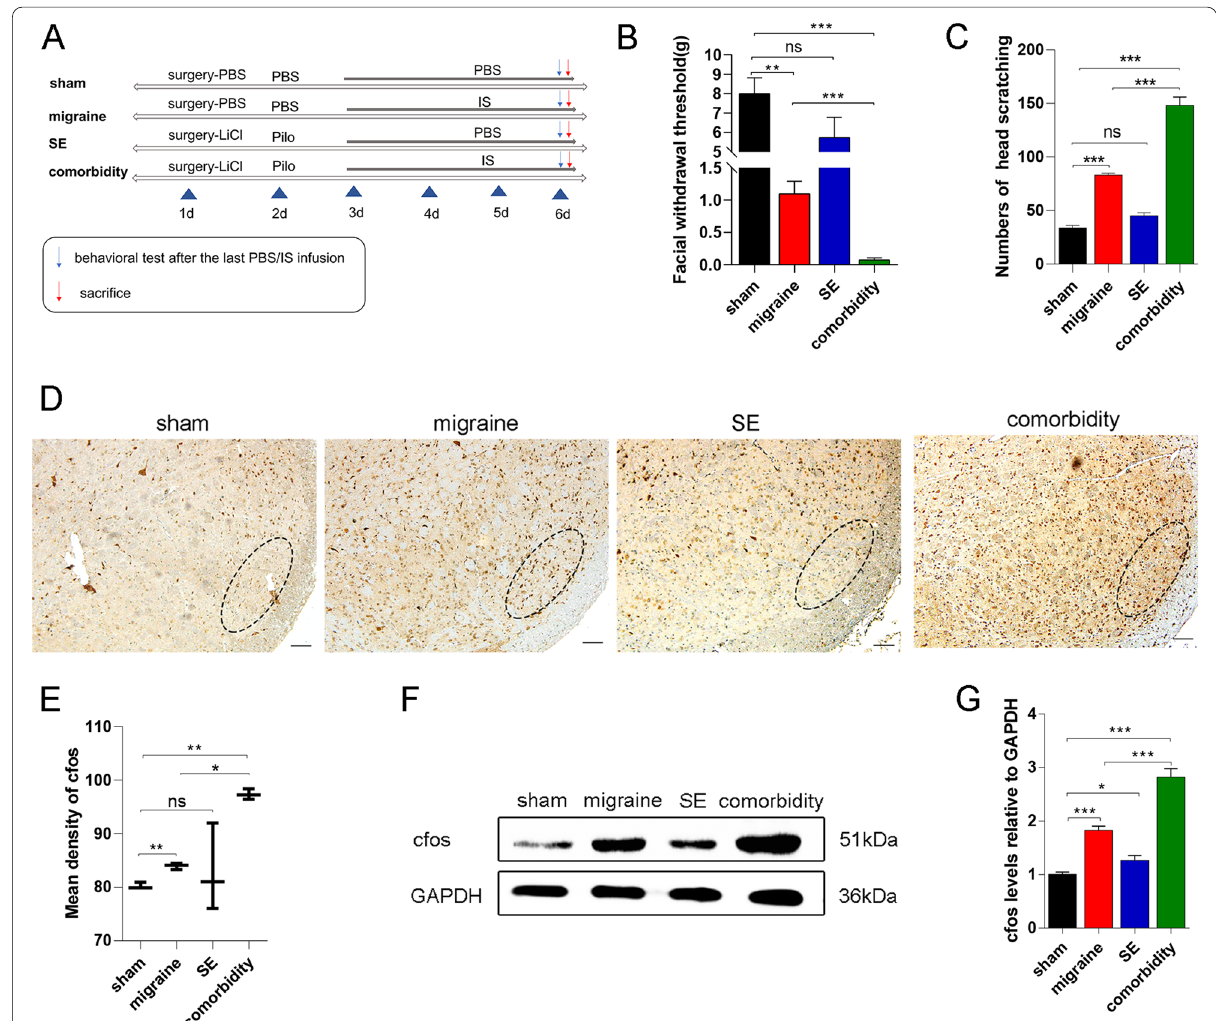
Fig. 1 SE-induced increase in nociceptive behaviour in migraine model rats. A Flow diagram of the experimental design. B, C Facial mechanical threshold and head-scratching counts were assessed in the different groups. Mean *** P < 0.001. D Representative immunohistochemical staining of cfos in the sp5c. Scale bars group. Mean SEM; one-way ANOVA, n 3 rats per group; * P < 0.05, ** P < 0.01. F, G Representative western blot results for cfos in the different ± = groups. Mean SEM; one-way ANOVA, n 3 rats per group; * P < 0.05, *** P < ± =